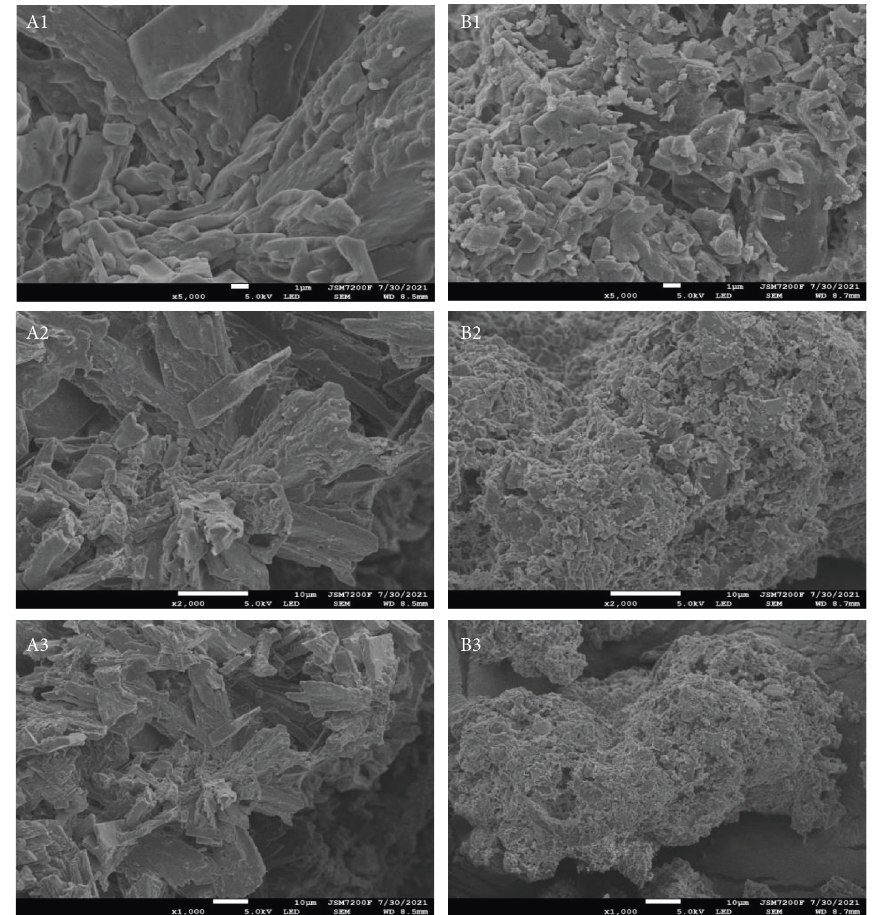
Figure 6: SEM images of the two spray-dried powders in 5000x, 2000, and 1000, respectively (A1–3 for sample A; B1–3 for sample B).